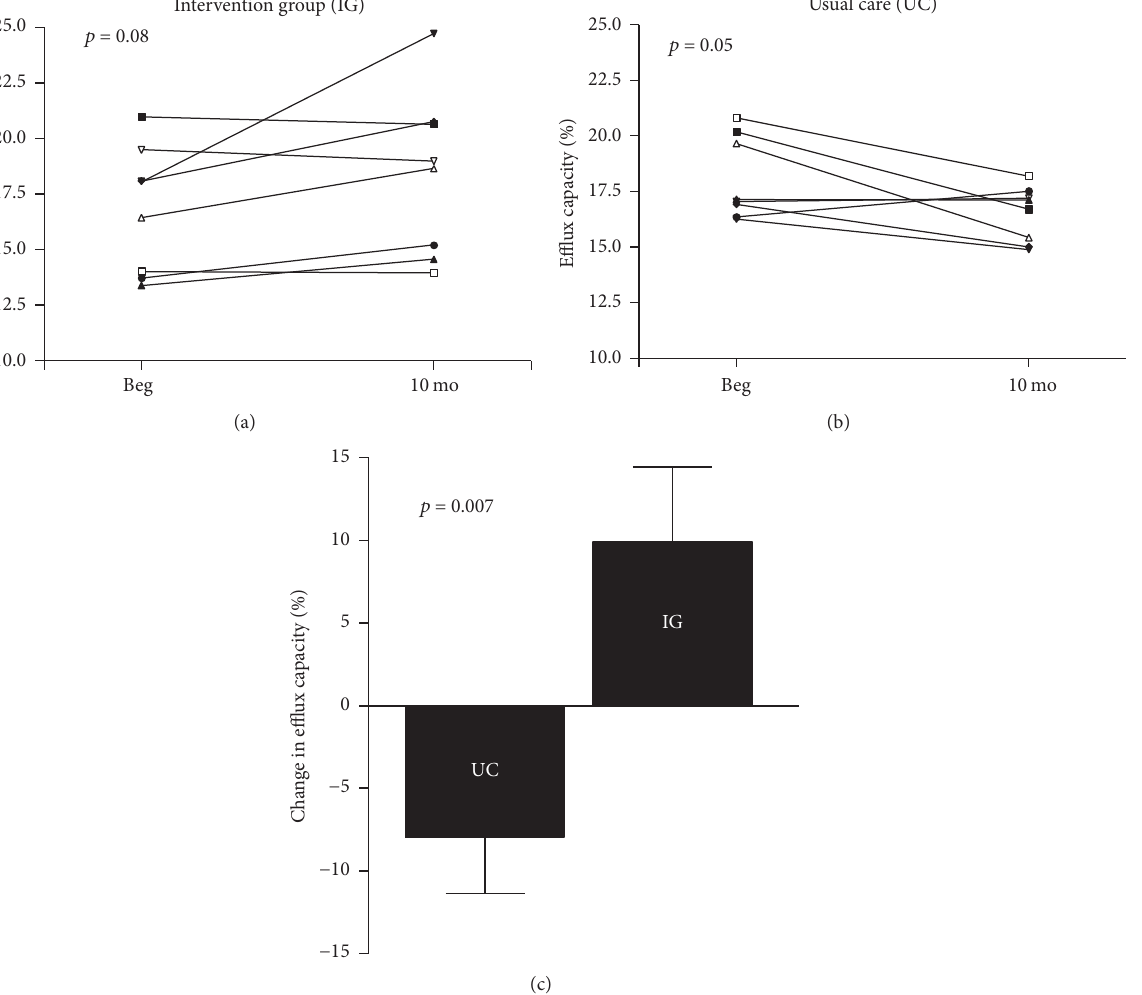
Figure 2: Impact of lifestyle intervention program on cholesterol efflux capacity. Individual changes were observed in the intervention group (IG) (a) and the usual care group (UC) (b). Comparing the change in cholesterol efflux capacity between IG and UC group (c) a significant difference was